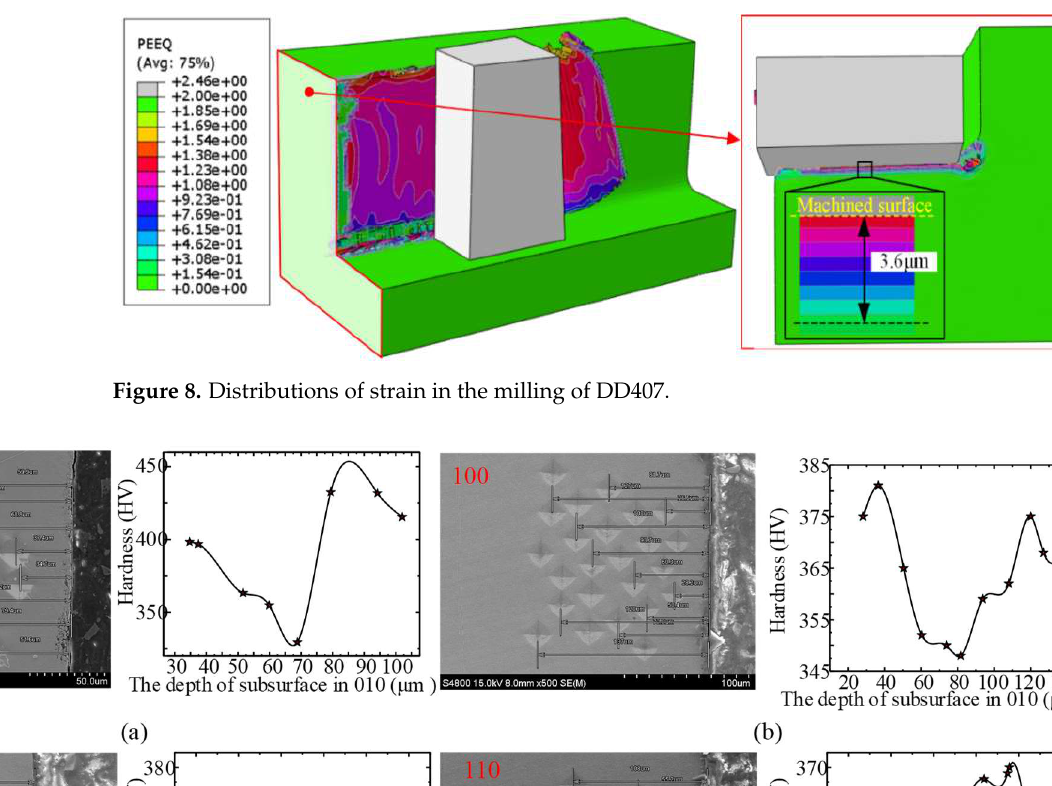
Figure 10. Cracks and lamellar structure were found in experiments and simulations.